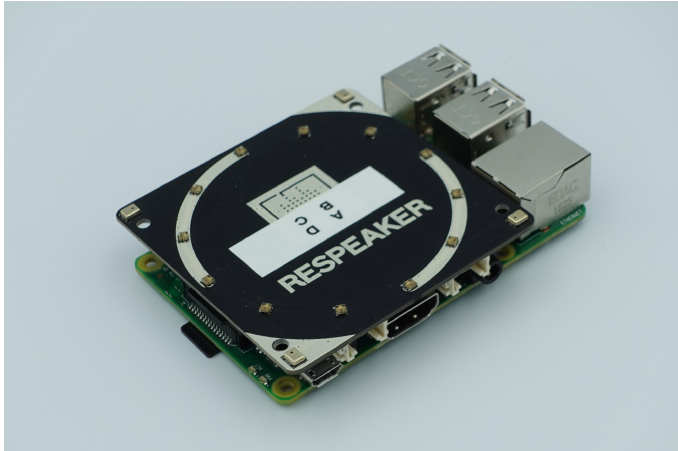
Figure 4. The stack of Raspberry Pi 3B+ SBC and microphone array module. Table 1. Selected properties of the MSM321A3729H9BP